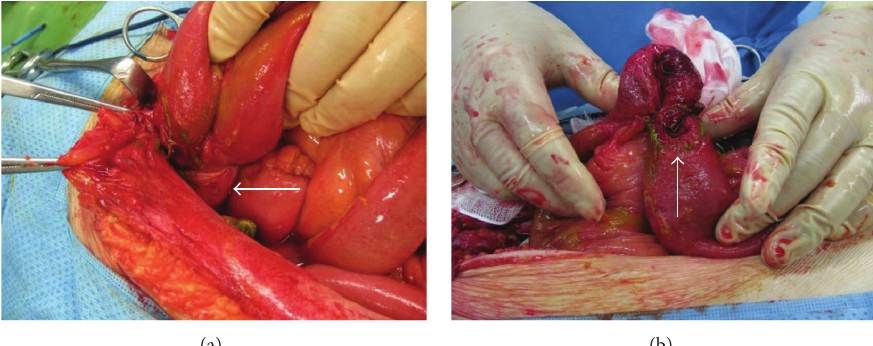
Figure 3: (a) Small bowel in the vicinity of the pubic bone, protruding into the abdominal cavity and surrounded by peritoneum. Each sac containing incarcerated small bowel has undergone reduction into the abdominal cavity. The arrow indicates the hernial sac that has undergone reduction en masse. The small bowel on the oral side has perforated at the point directly before the bowel enters the sac, and a hole that is the size of the head of an index finger has opened up. (b) The arrow shows the perforation in the small bowel after elimination of the reduction en